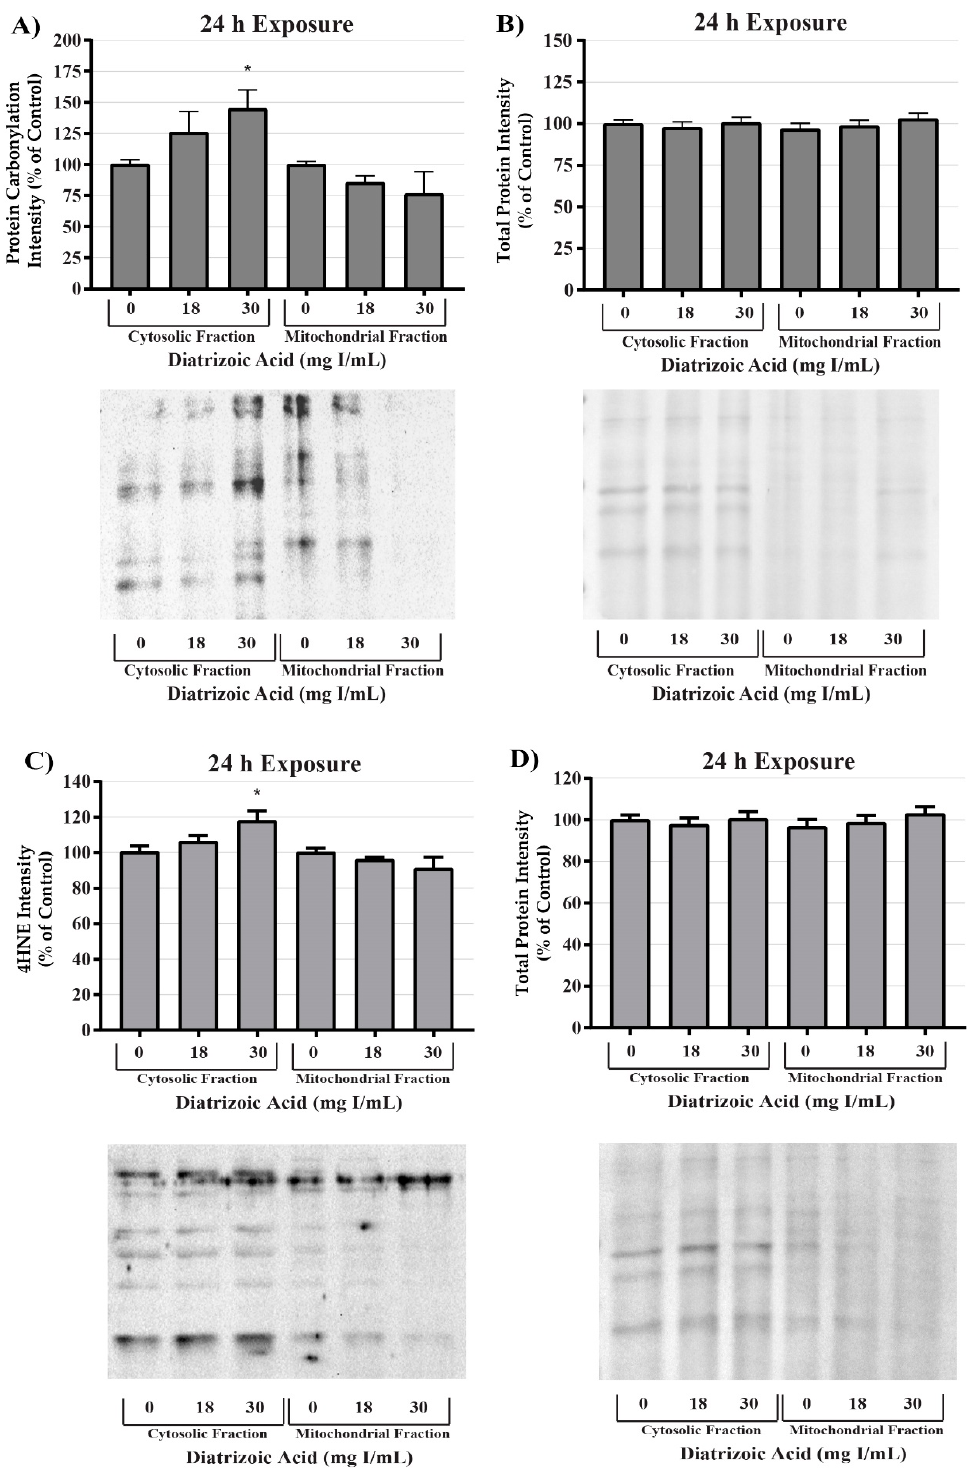
Figure 14. Diatrizoic acid effects on oxidative stress within cellular fractions of HK-2 cells. DA-induced oxidative stress predominantly in the cytosol. Representative blot and cumulative densitometry for expression of Oxyblot ( A ) and 4HNE protein adducts ( C ) in cytosolic and mitochondrial fractions following 24 h exposure to DA. Memcode reversible staining of blots loaded with 15 and 40 µg protein and densitometry for Oxyblot ( B ) and 4HNE ( D ). Asterisks (* p < 0.05) indicate statistical difference from vehicle control in cytosolic fraction. Values represent mean ± SEM for three independent experiments.